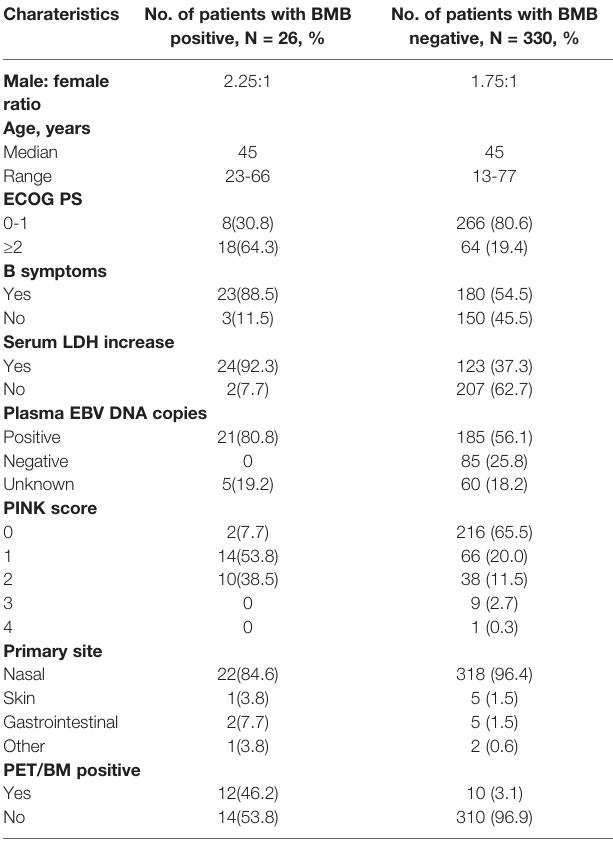
TABLE 2 | Baseline features of patients with bone marrow involvement versus. patients without bone marrow involvement by BMB (n = 356). Charateristics No. of patients with BMB No. of patients with BMB positive, N = 26, % negative, N = 330, %